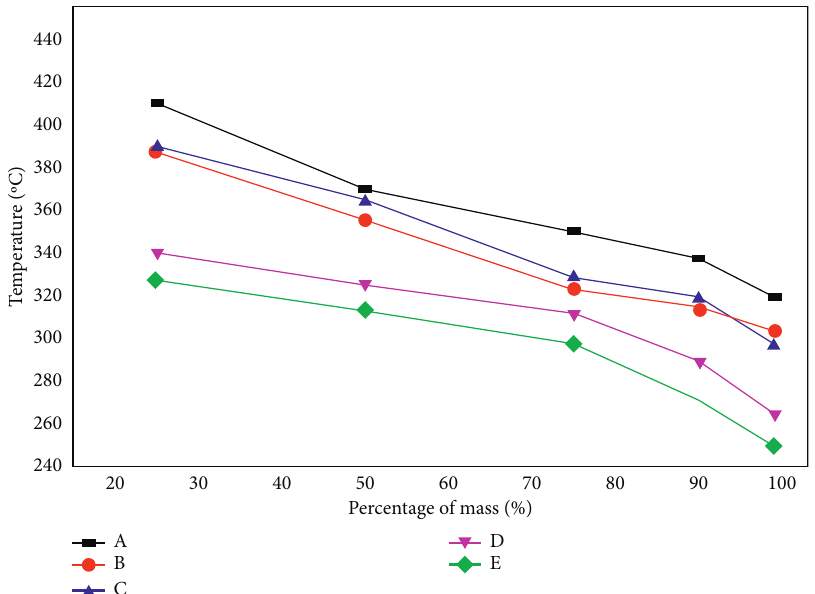
Figure 8: The graph between mass loss and temperature of the hybrid